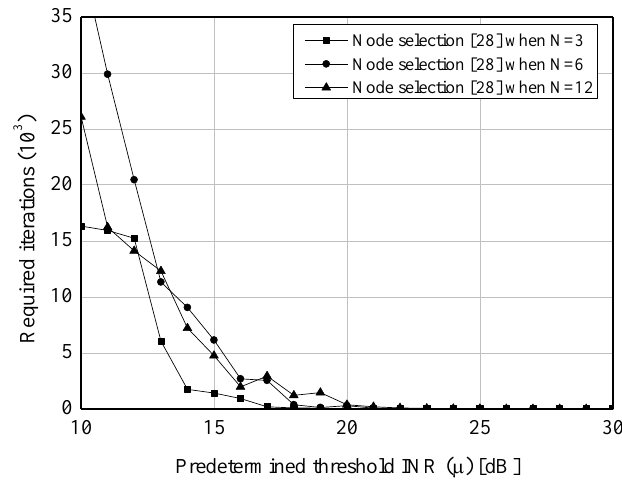
Figure 6. Performance of the sidelobe reduction algorithm—Search complexity for the node selection scheme [28].